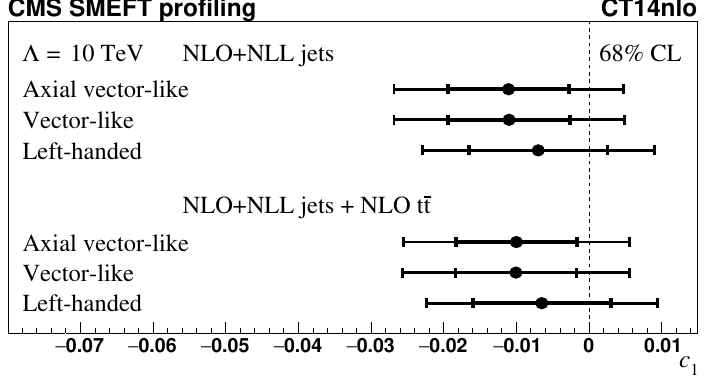
for the contact interaction models, assuming the Figure 13 . The profiled Wilson coefficient c 1 left-handed, vector-like, and axial vector-like scenarios, as obtained in the profiling analysis using NLO+NLL calculation for the jet production and the CT14nlo PDF set. The value of Λ = 10 TeV is assumed. The results are obtained using the CMS measurements of inclusive jet cross section √ and of normalised triple-differential tt cross section at s = 13 TeV. The inner error bar shows the PDF uncertainty at 68% CL, while the outer error bar represents the total uncertainty, obtained from the PDF and scale uncertainties, added in